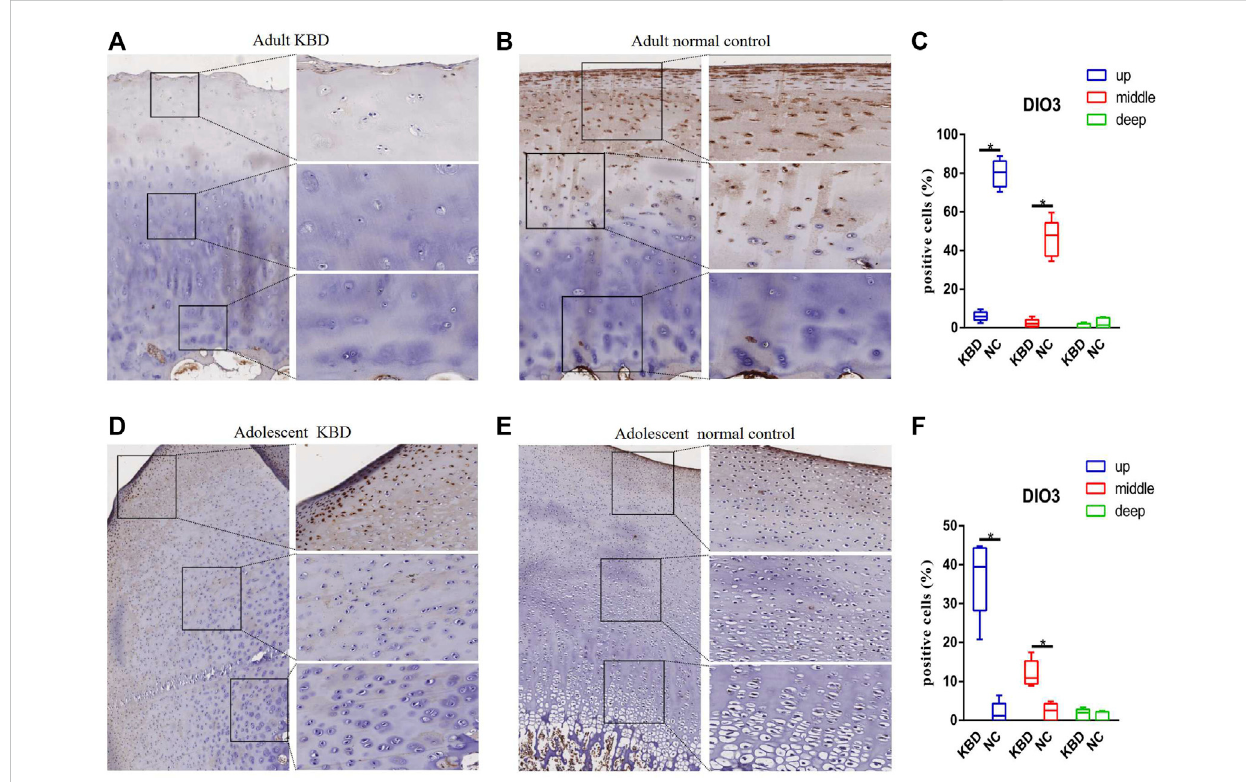
FIGURE 6 Representative immunohistochemistry staining of DIO3 in adult KBD (A) , adult normal control (B) , adolescent KBD (D) , and adolescent normal control (E) cartilagetissues(scalebar:left,500 μ m;right,100 μ m)andcomparativequanti fi cationofpositivecellsofdifferentareas(up,middle,anddeep) in adult (C) and adolescent (F) cartilage tissues displayed by a box plot ( n = 3). * p <